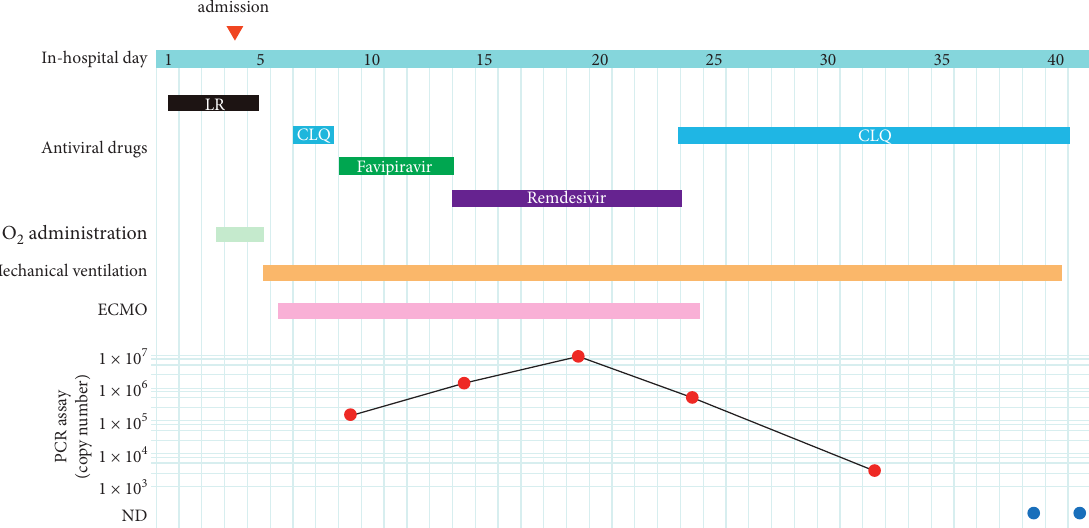
Figure 2: Clinical course of treatment. The viral load peaked on the 19 th day during the administration of remdesivir and then started to decrease. Red and blue circles indicate positive and negative results on PCR assay, respectively. LR, lopinavir/ritonavir; CLQ, chloroquine; ECMO, extracorporeal membrane oxygenation; PCR, polymerase chain